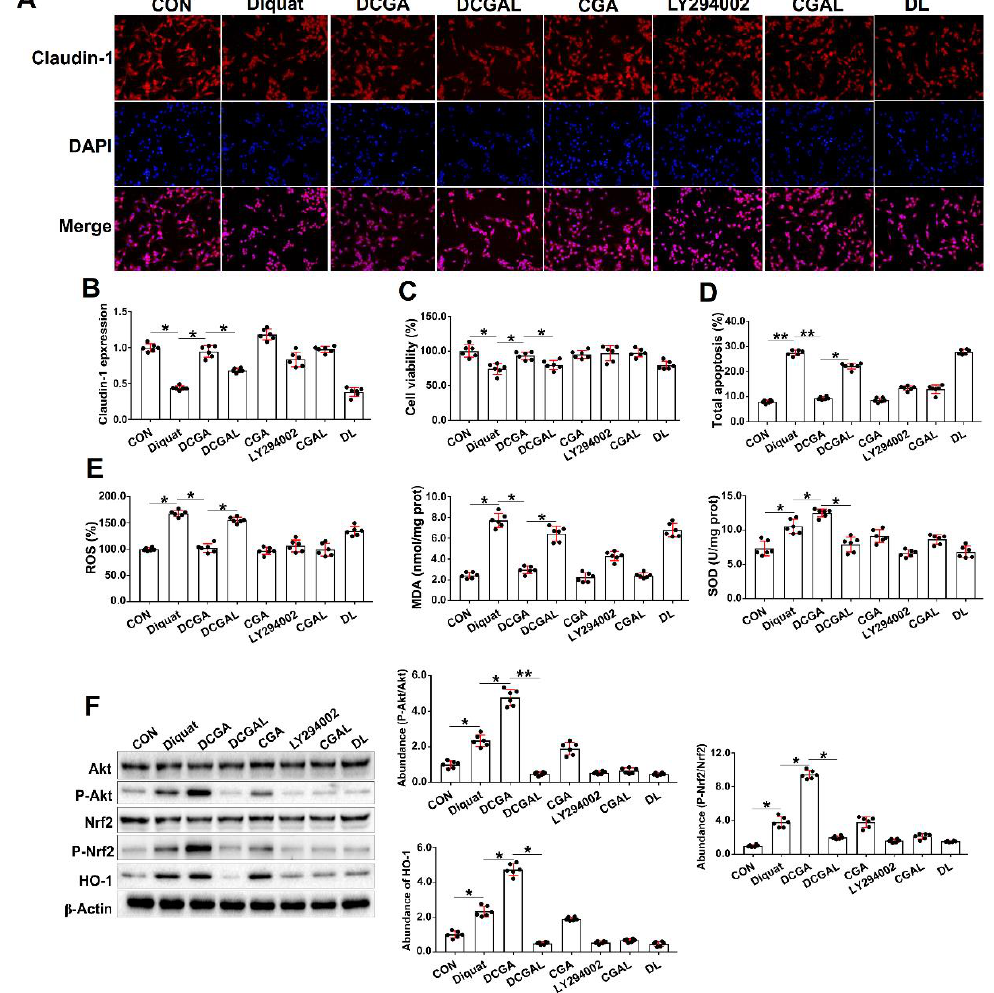
Figure 3. Chlorogenic acid (CGA) attenuates oxidative stress-induced injury in IPEC-J2 cells via phosphatidylinositol-3-kinase (PI3K)/protein kinase B (Akt) signaling. ( A ) Localization of the tight-junction protein claudin-1 by immunofluorescence staining. IPEC-J2 cells were plated in 24-well plates at a density of 1 × 10 5 cells/well ( n = 6). ( B ) qPCR analysis of the expression levels of claudin-1. ( C ) Assays of cell viability. ( D ) Analysis of cell apoptosis by flow cytometric assays. ( E ) Intracellular contents of oxygen reactive species (ROS), malondialdehyde (MDA), and superoxide dismutase (SOD). ( F ) Western-blot analysis of critical signaling proteins involved in the PI3K/Akt pathway. CON, cells without being treated; Diquat, cells were only treated by 100 µM diquat; CGA, cells were only treated by 100 µM CGA; DCGA, cells were pretreated by 100 µM CGA for 6 h and were then treated by 100 µM diquat for 3 h. DCGAL, cells were pretreated by 10 µM LY294002 for 1 h and were then treated by 100 µM CGA and 100 µM diquat; LY294002, cells were only treated by 10 µM